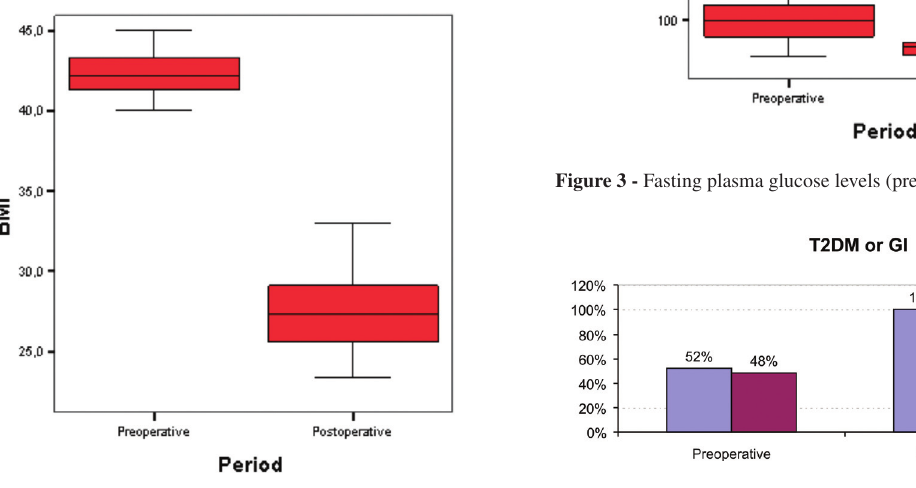
Figure 4 - Prevalence of T2DM and glucose intolerance